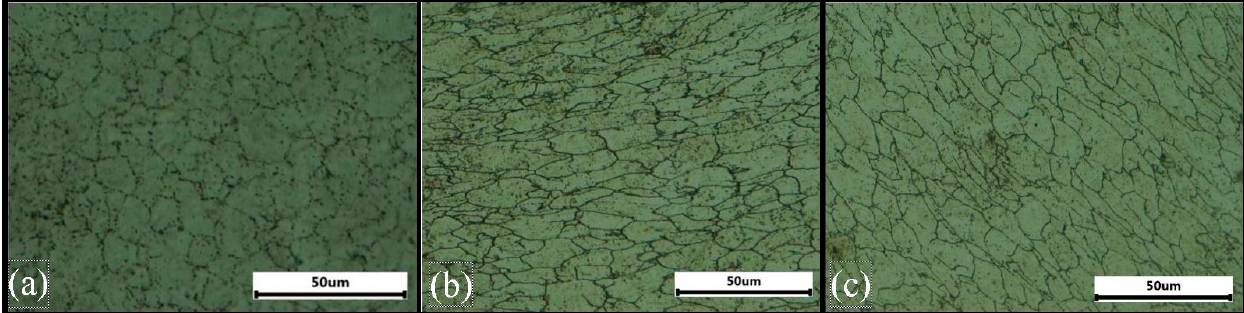
Figure 4. Metallographic observation of SS316L ( a ) before ECAP, ( b ) 120° ECAP and ( c ) 126° ECAP.